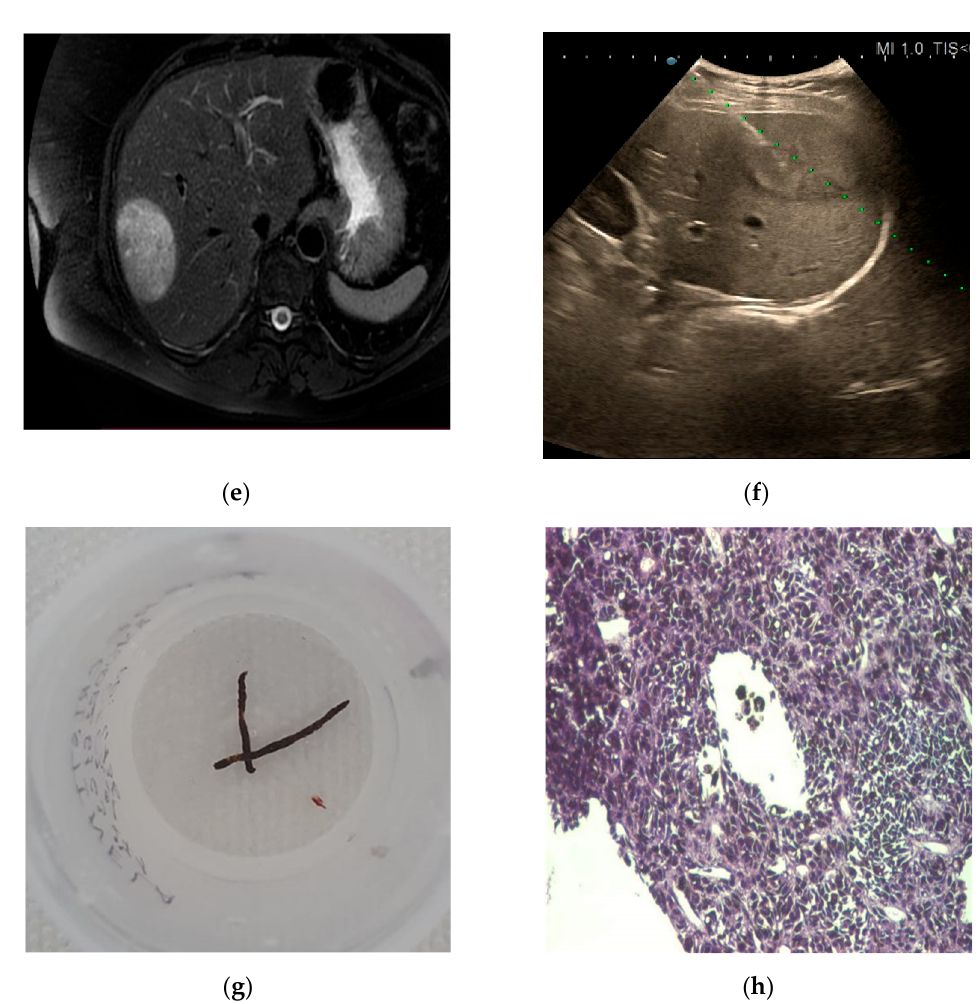
Figure 9. A case of liver metastases detected in a 64-year-old woman with chronic hepatitis B, LI-RADS-M aspect. The ultrasound exam shows a hyperechoic lesion with a halo in the right liver lobe ( a ). On CEUS, the liver lesion shows an arterial phase enhancement ( b ). In the portal phase an early washout was noticed ( c ), followed by marked washout in the late phase ( d ). The aspect of focal liver lesion on the CT scan ( e ). Echo-guided liver biopsy was performed ( f ). Two black liver fragments ( g ) with melanoma histological aspect were obtained (×40) ( h ).